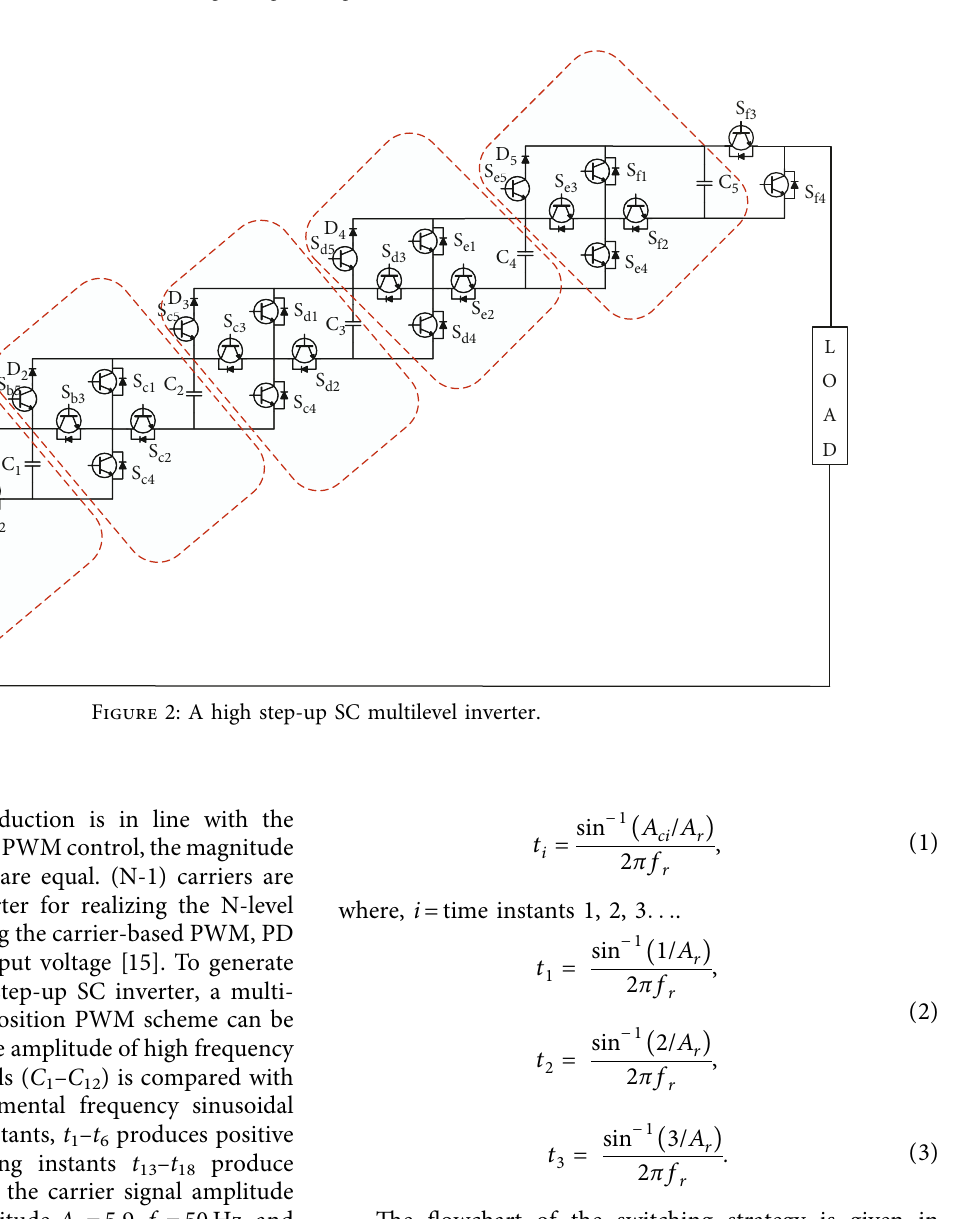
Figure 1: A single-stage voltage source inverter